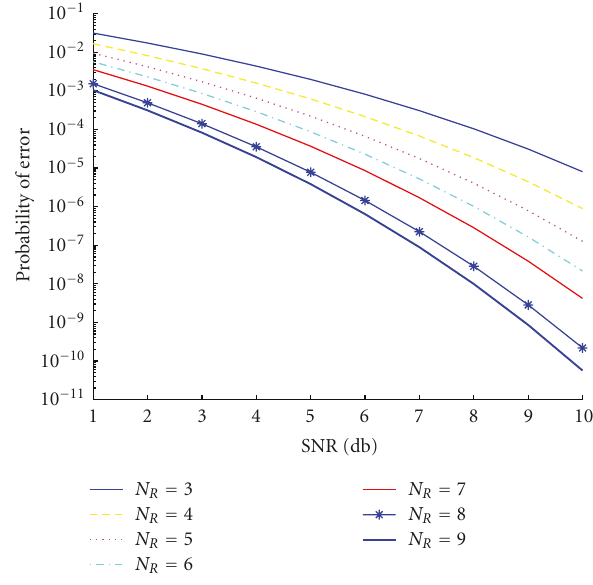
Figure 2: Theoretical probability of errors.